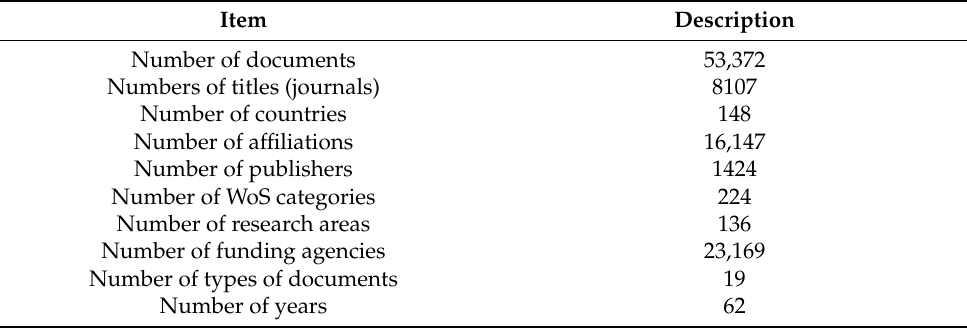
Table 2. General characteristics of searching